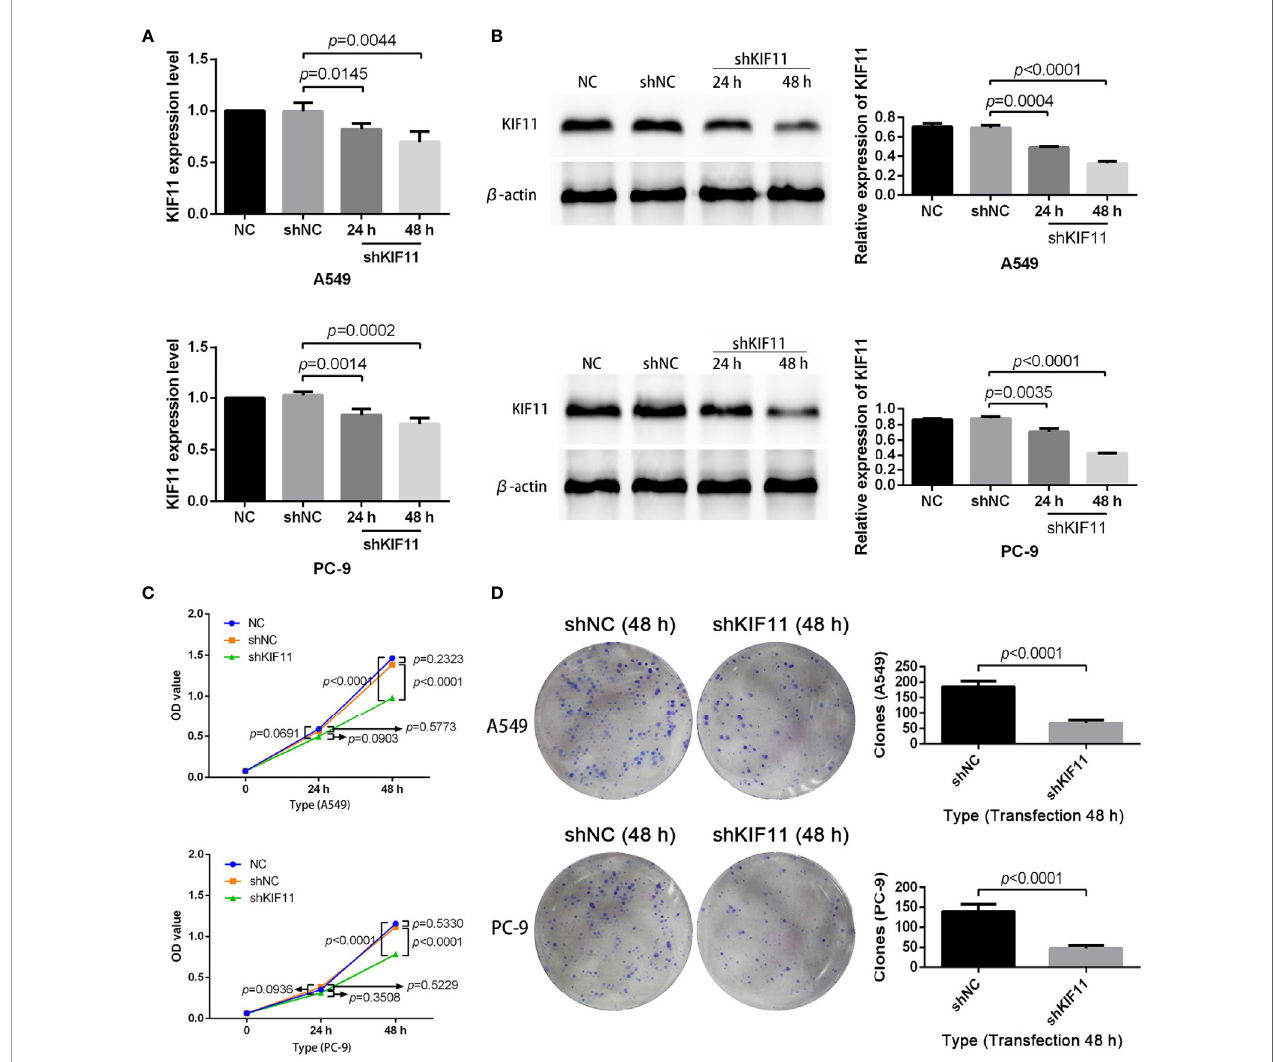
FIGURE 8 | KIF11 knockdown inhibited the proliferation of LUAD cells. Ef fi ciency of the KIF11 knockdown as determined by (A) quantitative real-time PCR and (B) Western blot analysis. Inhibitory effect of KIF11 knockdown on cell growth as measured by (C) CCK-8 test and (D) colony formation